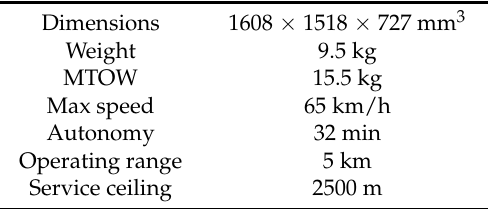
Figure 13. Sensors 2018 , 18 , x FOR PEER REVIEW